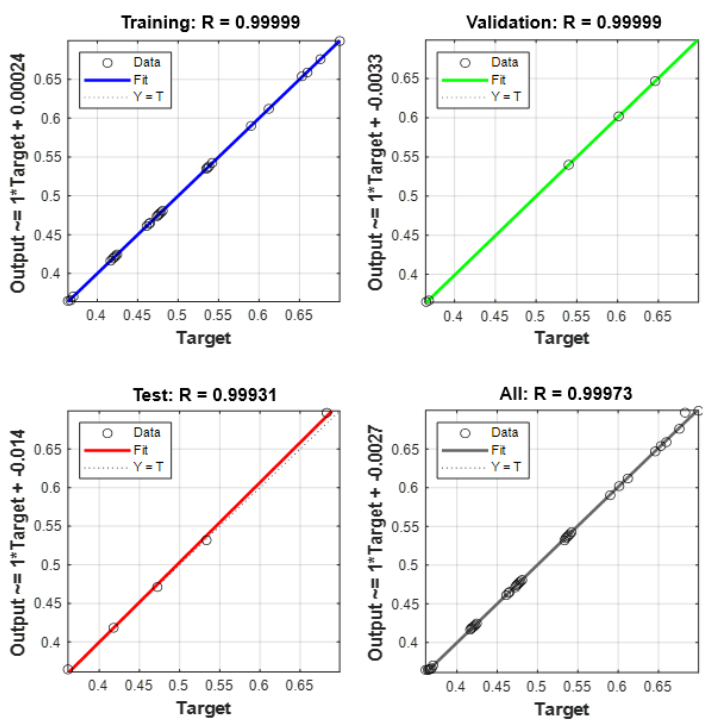
Figure 10. Training parameters of the neural network.